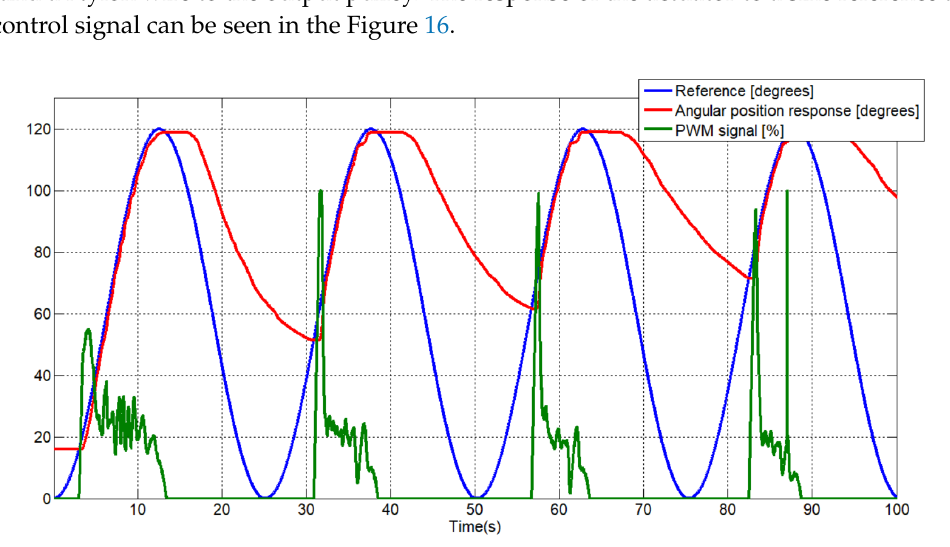
Figure 16. SMA-based actuator with gear 1:4